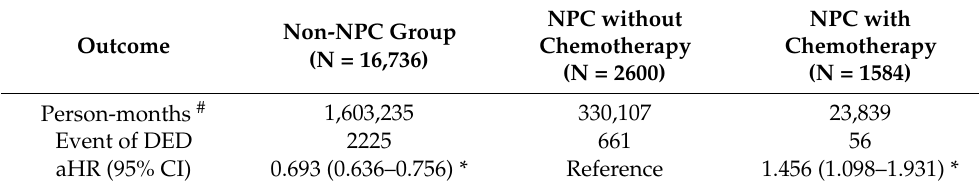
Table 5. Outcomes for the patients with nasal pharyngeal carcinoma stratified by chemotherapy and individuals without nasal pharyngeal